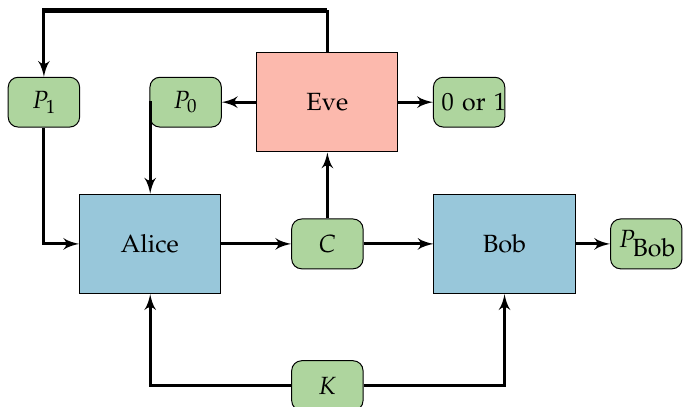
Figure 2. Alice, Bob, and Eve, and the CPA-ANC setup. Alice and Bob share a secret key K . Eve chooses two messages P 0 and P 1 . Alice randomly chooses one message to encrypt producing the ciphertext C . Bob uses the key K to decrypt C producing P Bob. Eve receives the ciphertext C and tries to guess which message was encrypted outputting 0 if believes P 0 was encrypted and 1 if believes P 1 was